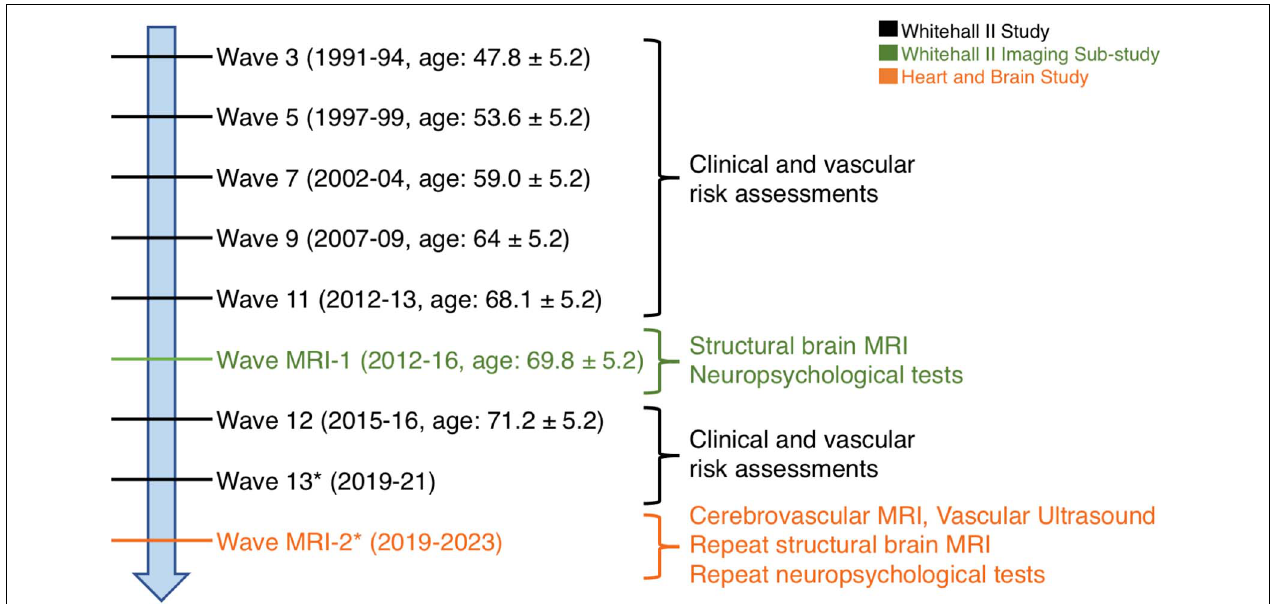
FIGURE 1 | Study and cohort design. Clinical and vascular risk information was collected at the seven out of 13 waves of the Whitehall II Study, marked in black. APOE genotyping was performed at Wave 7. Brain MRI and cognitive assessments were collected at Wave MRI-1 (Whitehall II Imaging Sub-study), marked in green. A sub-set of the MRI and cognitive protocol are repeated at Wave MRI-2 ( Heart and Brain Study ), with novel cerebrovascular MRI and vascular ultrasound scans, marked in orange. *Indicates waves that are in progress at the time of publication.